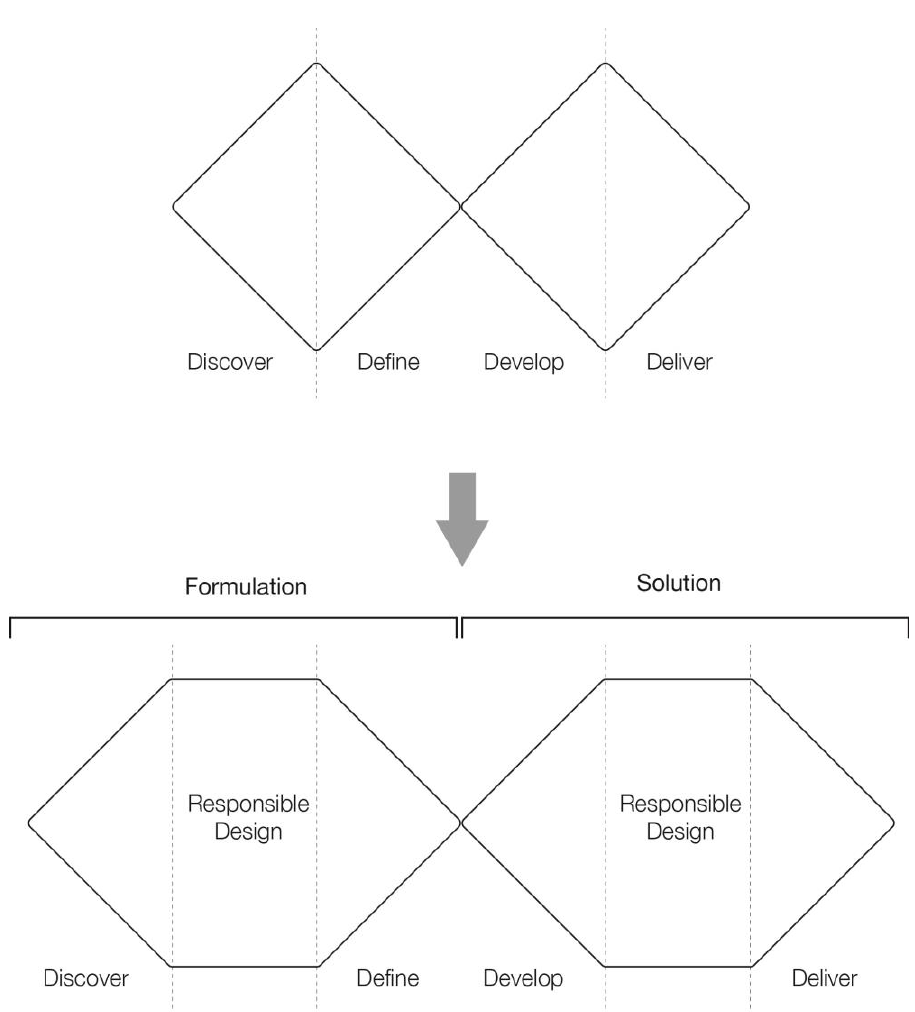
Figure 2. Responsible design before delivery. Original work adapted from [57].